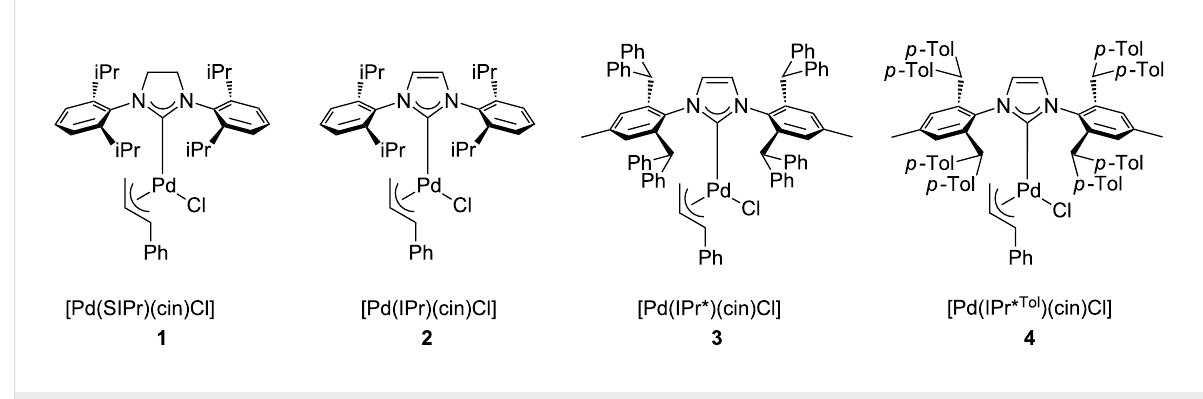
Figure 1: [Pd(NHC)(cin)Cl] catalysts examined in direct arylation.